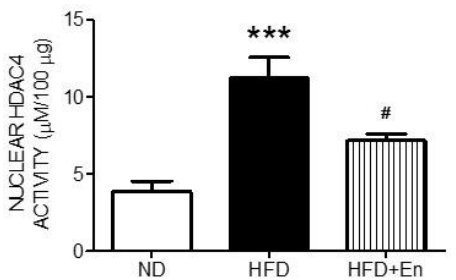
Figure 5. Enriched housing counteracted maternal HFD-increased nuclear HFDAC4 activity in the hippocampus at 12 weeks old. Values were mean ± SEM, ND: n = 12; HFD: n = 12; HFD + En: n = 6. *** p < 0.001 indicate significant di ff erences from the ND group and # p < 0.05 indicate significant di ff erences from the HFD group using a post-hoc Tukey’s multiple range test. ND: female offspring exposed to a maternal normal diet; HFD: female offspring exposed to a maternal high-fructose diet; Mc-1568 (Mc), 5 µ M by icv infusion for 4 weeks.